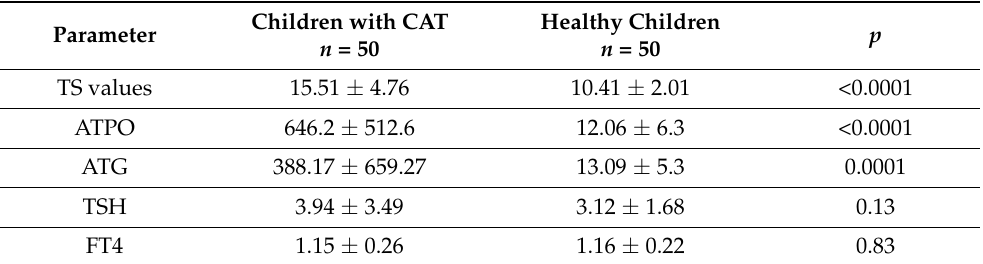
Table 4. Comparison between TS values and laboratory parameters in children with CAT vs. healthy children.